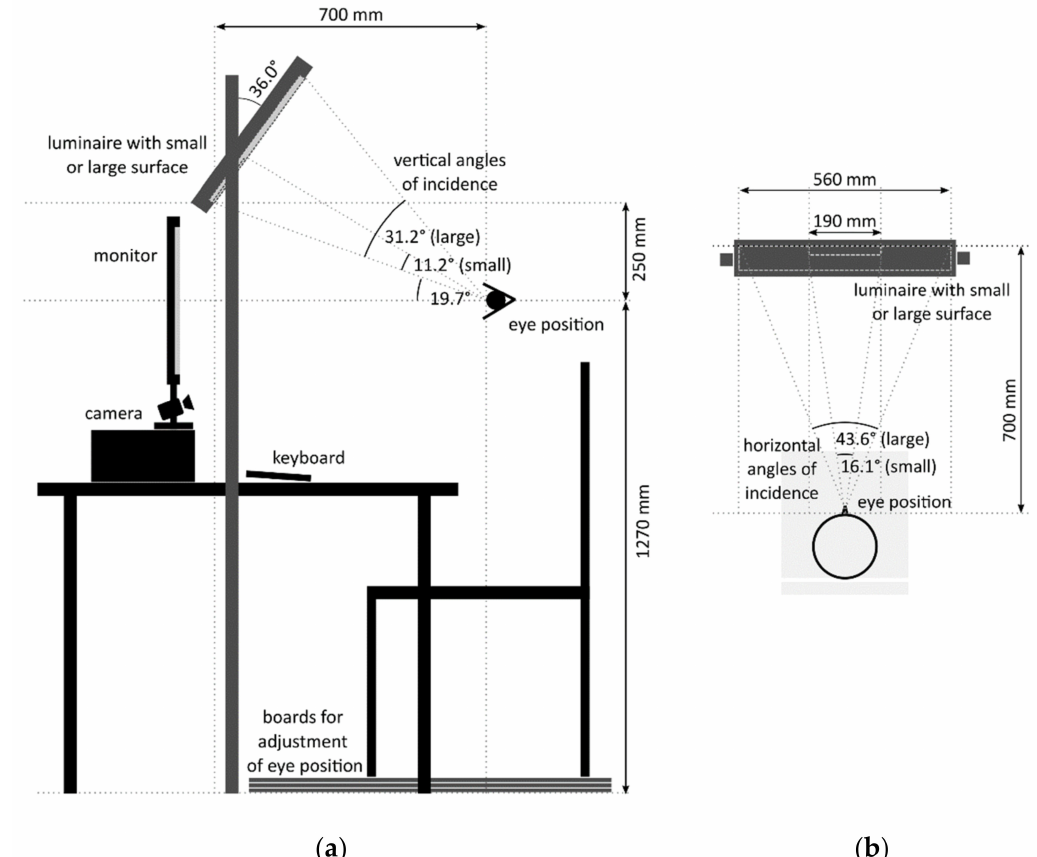
Figure 1. Side ( a ) and top view ( b ) of the experimental setup, illustrating the position of the subjects’ eyes and the angles of incidence. The angles refer to the two test conditions with a small (11.2 ◦ vertical, 16.1 ◦ horizontal) and large (31.2 ◦ vertical, 43.6 ◦ horizontal) solid